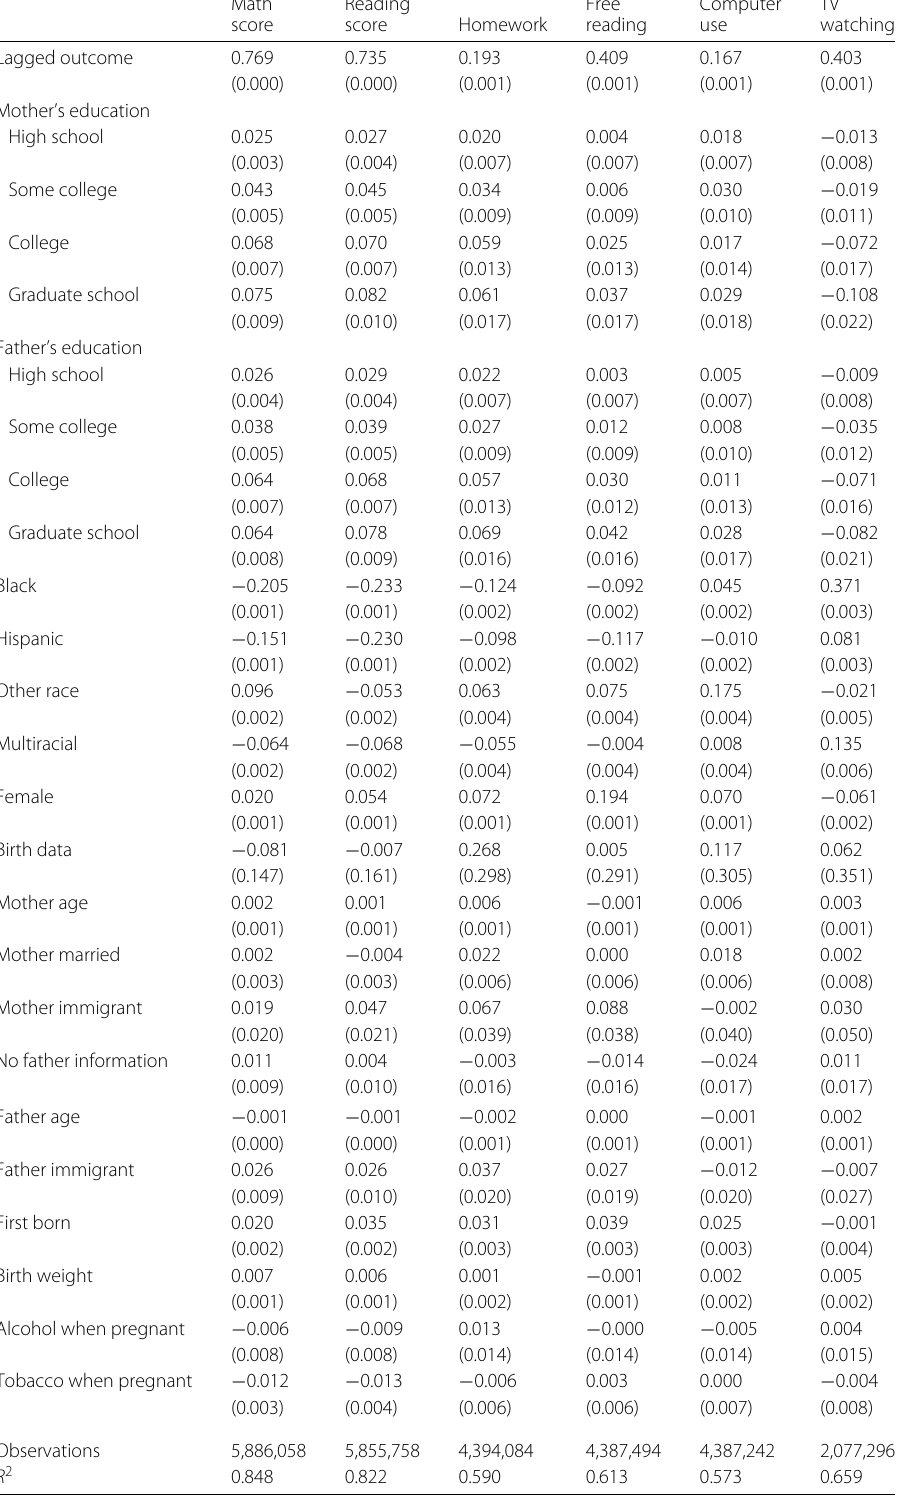
Table 7 Outcome regression results